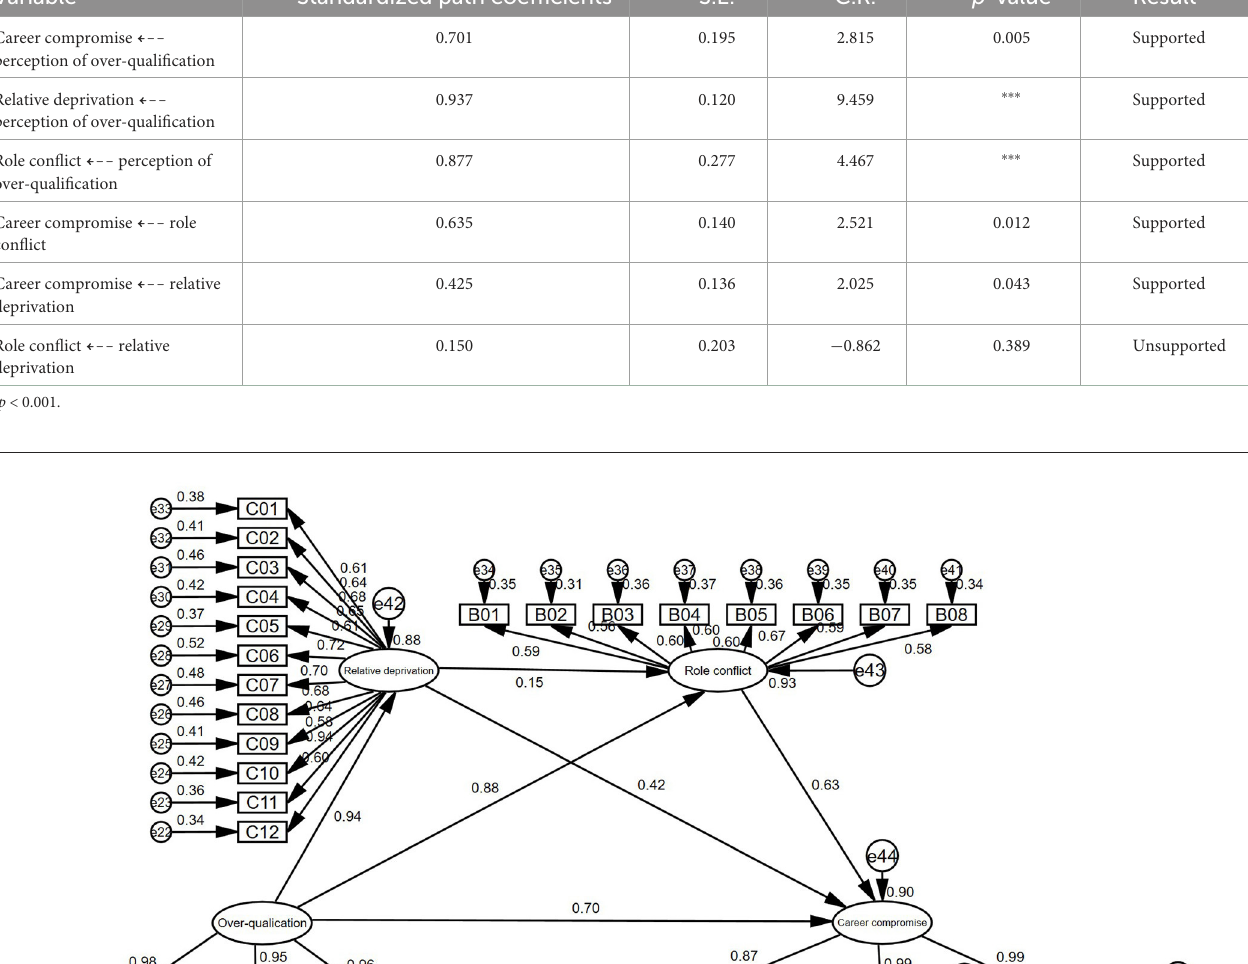
of the position and salary they deserve, which leads to anger and generation mechanism of role conflict (Zhao and Peng,